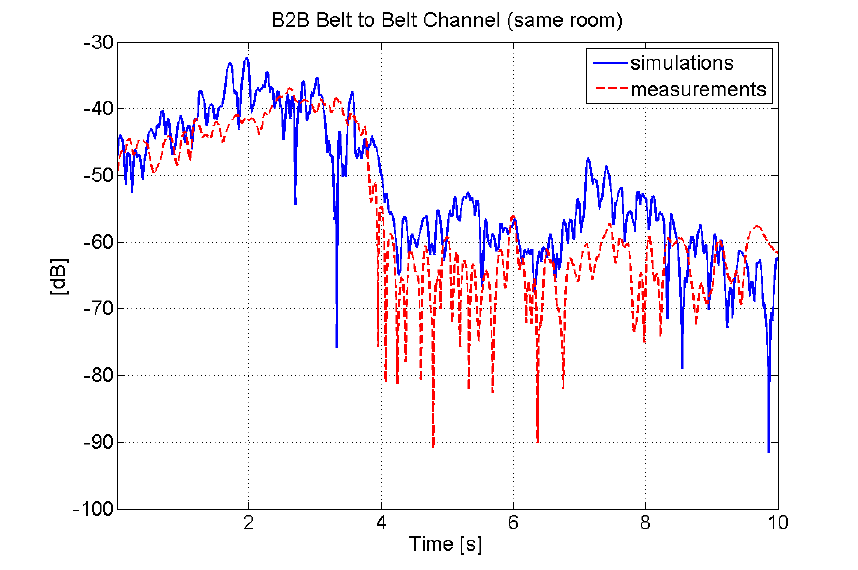
Figure 9. Comparison between measured and implemented belt-to-belt body-to-body (B2B)